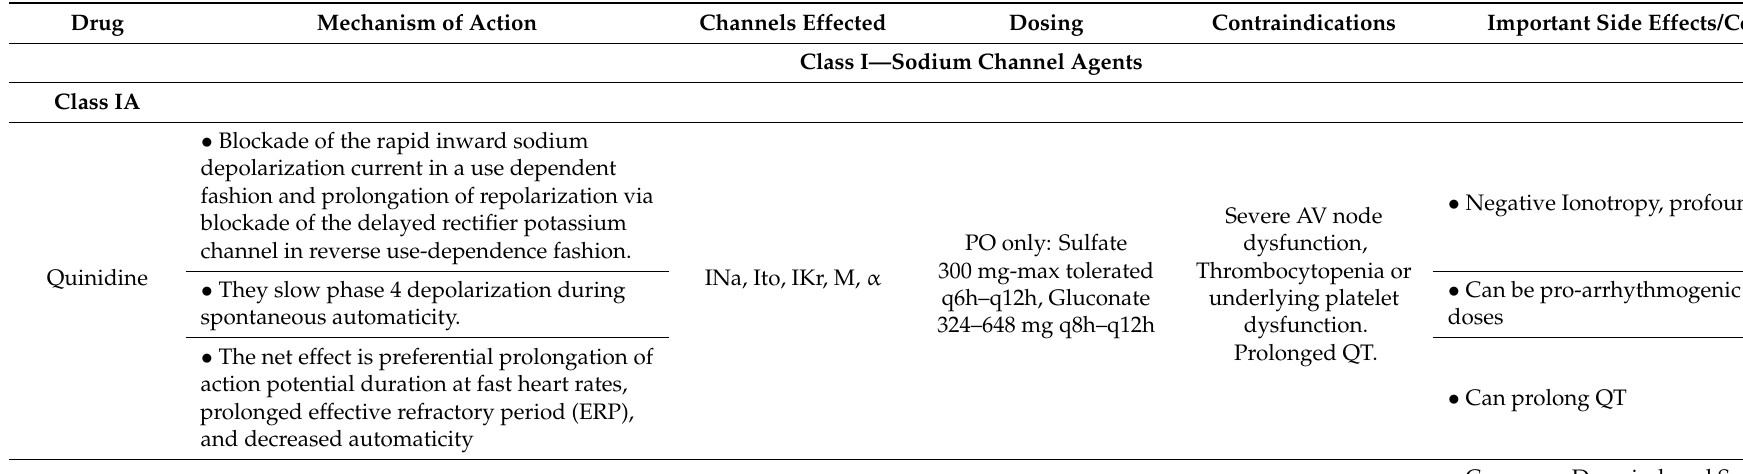
Table 1. Pharmacologic characteristics of all medications by Vaughan–Williams classification, including major side effects and